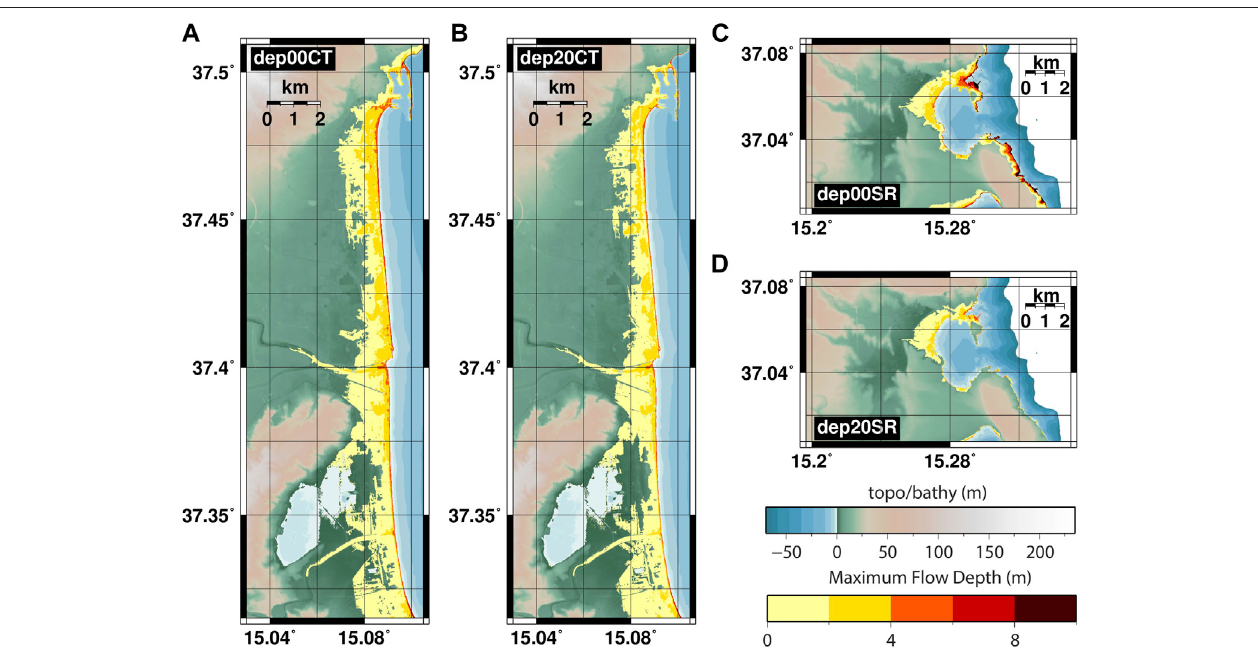
FIGURE 15 | Maximum fl ow-depth in meters recorded for simulations with strike (cid:1) 0 o , rake (cid:1) 90 o , and dip (cid:1) 70 o with depth 0 km (panels (A,C) ) and depth 20 km (panels (B,D) ).